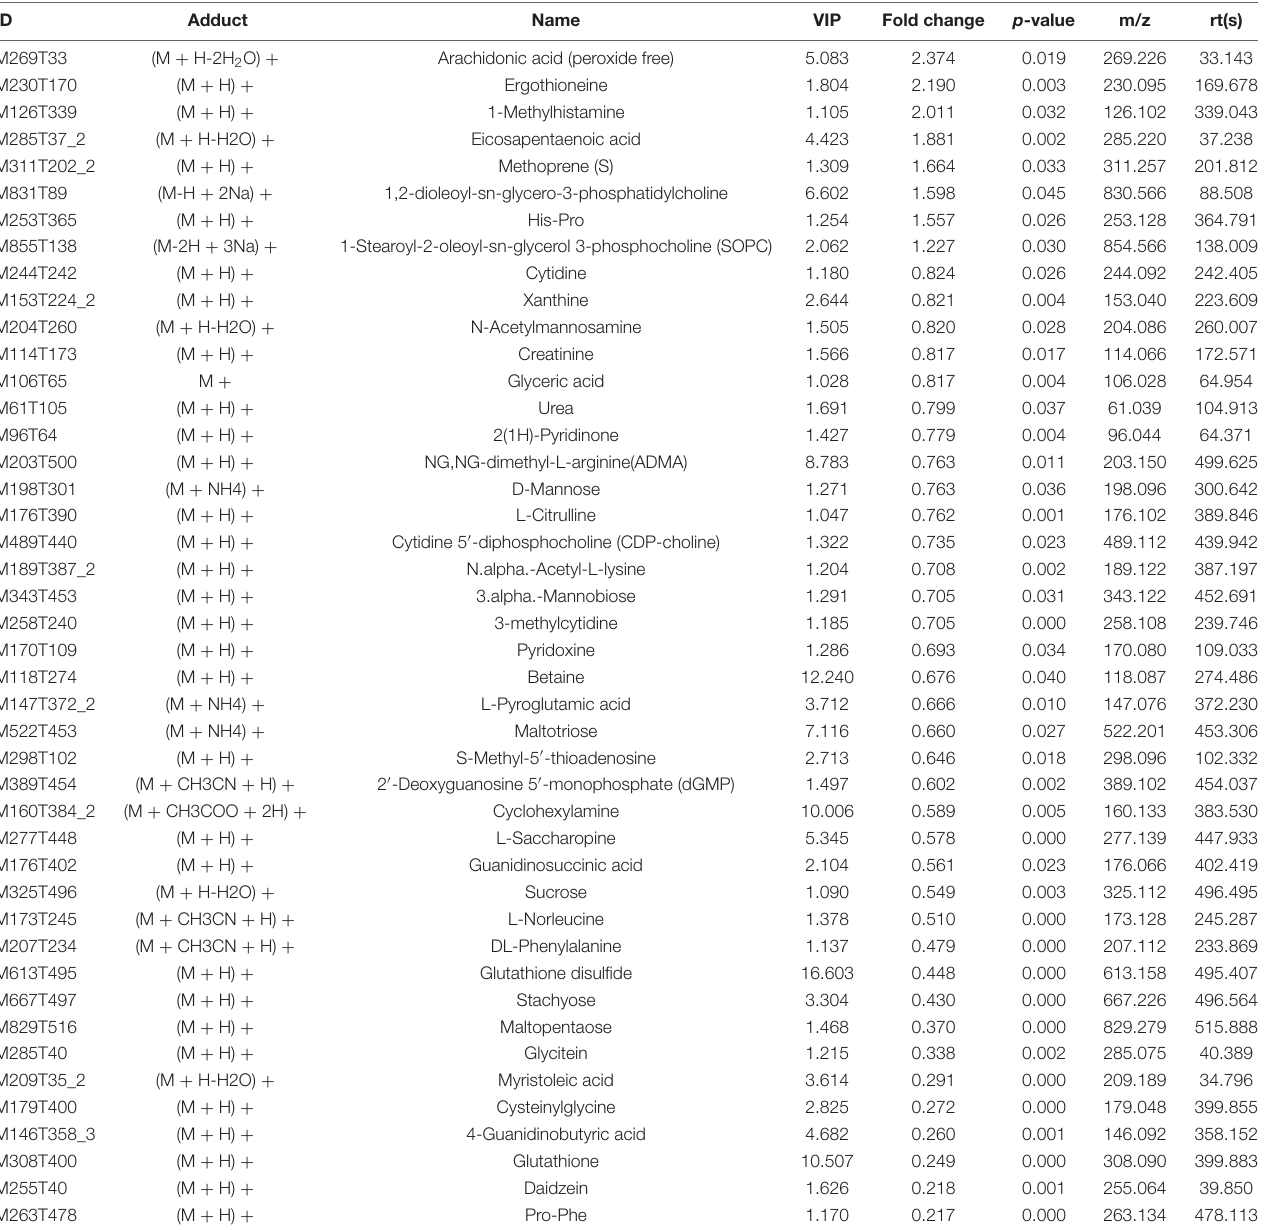
TABLE 1 | The differential metabolites in positive ion